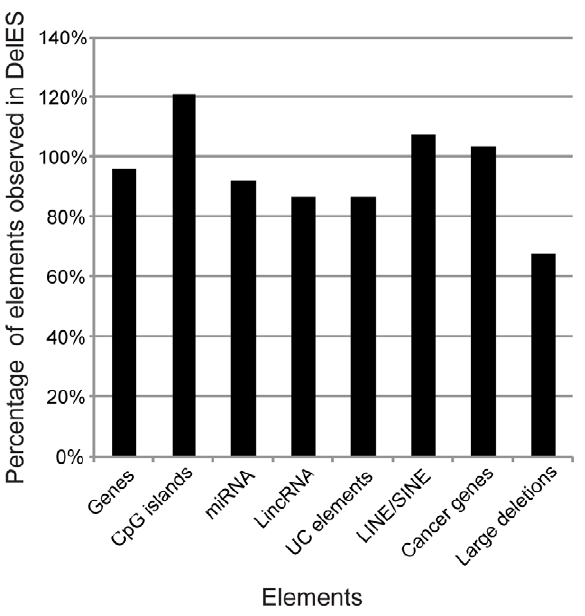
Figure 3. Genomic coverage of DelES. According to a hypothetical random distribution of elements throughout the murine genome, the indicated features mapped in DelES deletions were proportionally represented. Numbers used for the calculation were extracted from the following sources: MGI [49] for genes, miRBase13 [43] for miRNAs, Ensembl for CpG islands and LINE/SINE [44], the Wellcome Trust Sanger Institute website [50] for cancer related genes and large deletions linked to cancer, and a previous report [18] for ultraconserved (UC) elements.